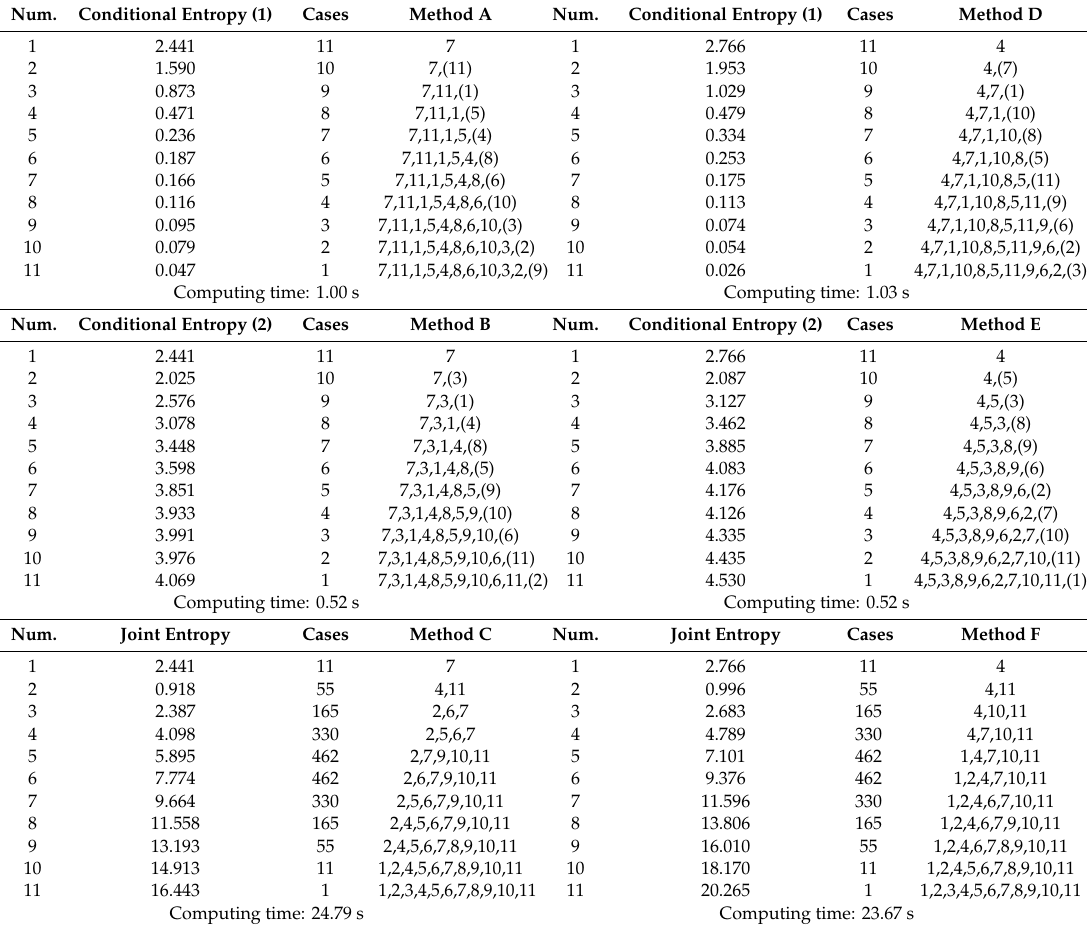
Table 2. Results of a select optimal rain gauge network of methods